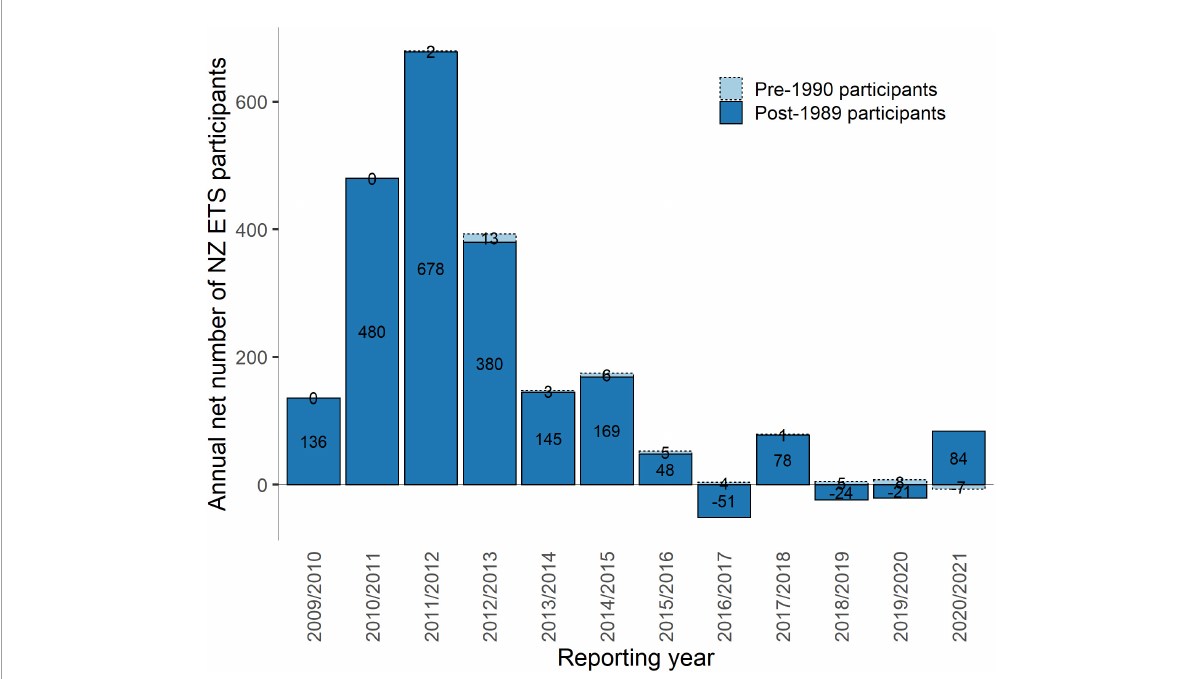
FIGURE3 Annual net number of NZ ETS participants (i.e., the number of added participants minus any removed participants) for pre-1990 and post-1989 forest land by reporting year. Note the number of pre-1990 forestry participants reflect those who reported deforestation. The reporting year runs from 1 July to 30 June. Data from EPA (2021).